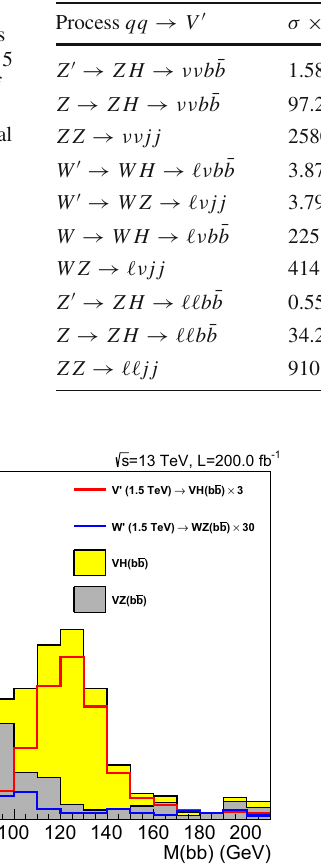
Fig. 9 Reconstructed bottom anti-bottom quark invariant mass for SM V H → (cid:3)(ν)(cid:3)(ν) b ¯ b and V Z → (cid:3)(ν)(cid:3)(ν) b ¯ b production (stacked yel- low and gray histograms, respectively), for an integrated luminosity of 200 fb − 1 . The HVT model predictions for M V (cid:3) = 1 . 5 TeV and g V = 5, with V H shown in red and W H in blue, are overlaid. The plot includes all final states with 0, 1 and 2 leptons. A p ⊥ > 300 GeV cut has been applied to the b ¯ b